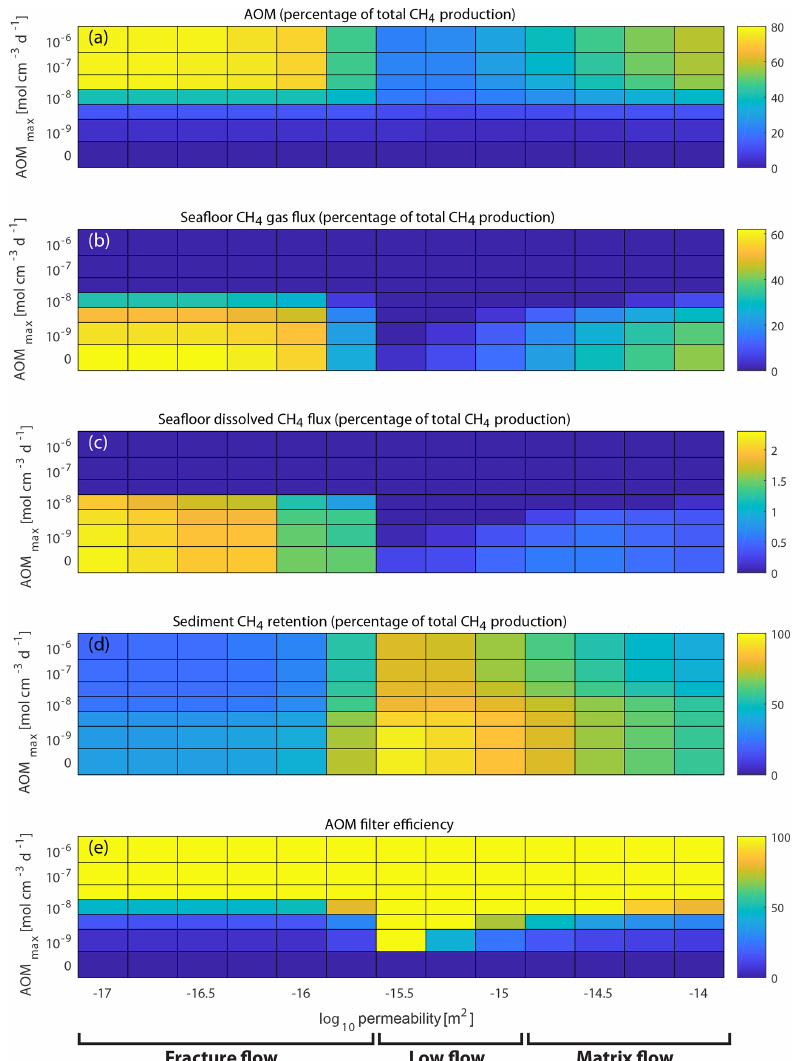
Figure 6. Case A1–A7 simulation results after 100 years (each tile represents one model simulation). Panels (a) – (d) show percentages of the total CH 4 production from hydrate dissociation after 100 years, which is identical in all cases and equal to 53kgm − 2 (the sum of panels a – d equals 100%). (a) The total cumulative AOM increases with increased AOM max rates but is also a function of the vertical CH 4 flow rate within the sediments (highest values for the fractured flow regime, lowest values for the low-flow regime and intermediate values for the matrix flow regime). (b, c) The cumulative CH 4 release ( b , gaseous; c , dissolved) decreases with increased AOM max and also reflects vertical CH 4 flow rates within the sediments (as discussed above). (d) Sediment CH 4 retention is weakly dependent on AOM max (some of the CH 4 that would reside within the SRZ in the zero AOM case would instead be consumed by AOM) but generally reflects the vertical CH 4 flow rates. (e) The AOM filter efficiency is defined as the fraction of CH 4 escape reduction compared to the corresponding zero AOM case (Case A1). For cases with AOM max larger than 10 − 8 cm − 3 d − 1 , the model predicts that the microbial filter is 100% effective, regardless of permeability, meaning that no CH 4 can escape from the seafloor. For lower AOM max rates, the picture is more